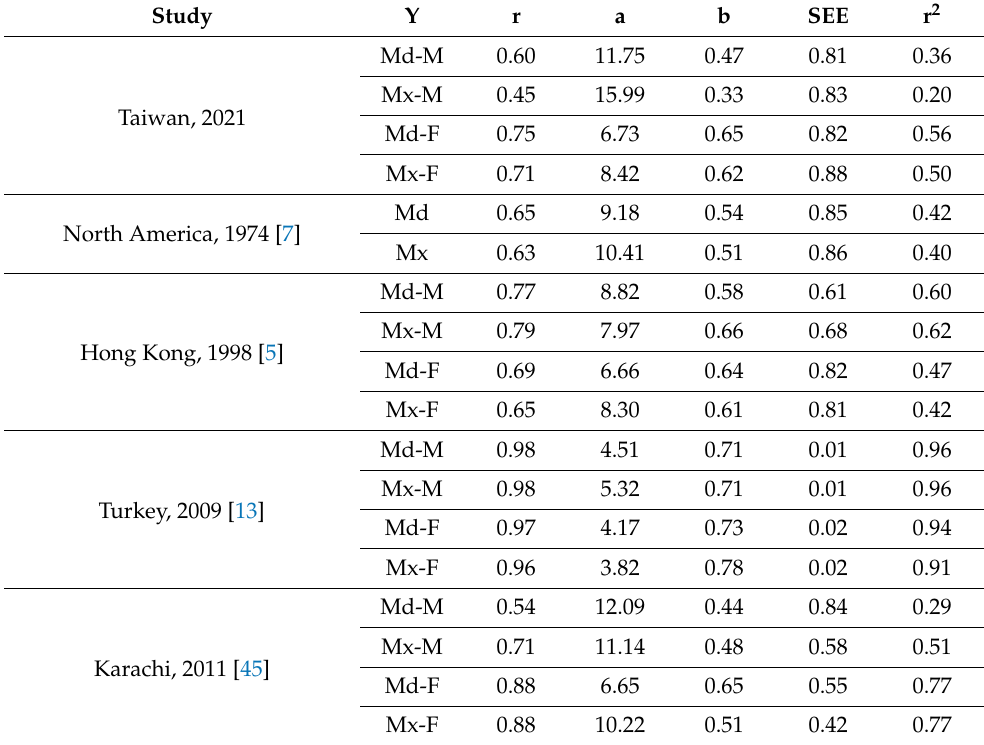
Table 6. Comparison of regression parameters among different populations.